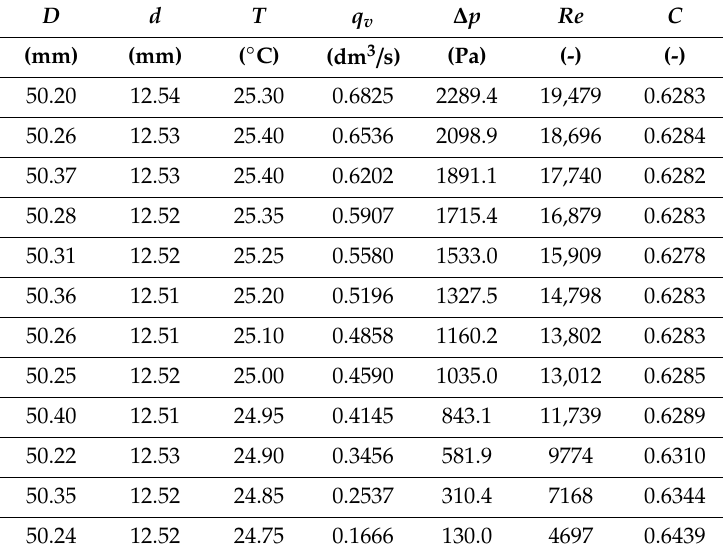
Table 1. Results of experimental